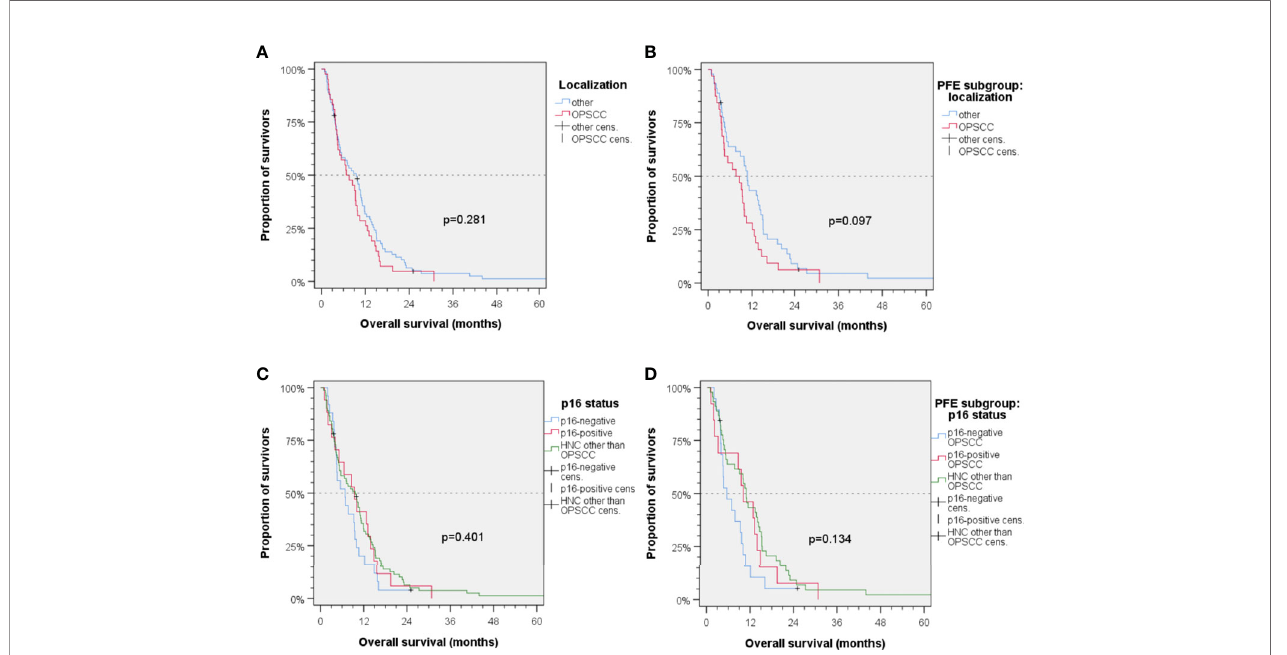
FIGURE 3 | Kaplan – Meier plots for cumulative overall survival (OS 1L-ChT ) measured from diagnosis of incurable recurrent/metastatic head and neck squamous cell carcinoma (A, C) in the total cohort and (B, D) PFE treated patients. (A) OS 1L-ChT for OPSCC vs. index HNSCC outside the oropharynx; (B) OS 1L-ChT after PFE for